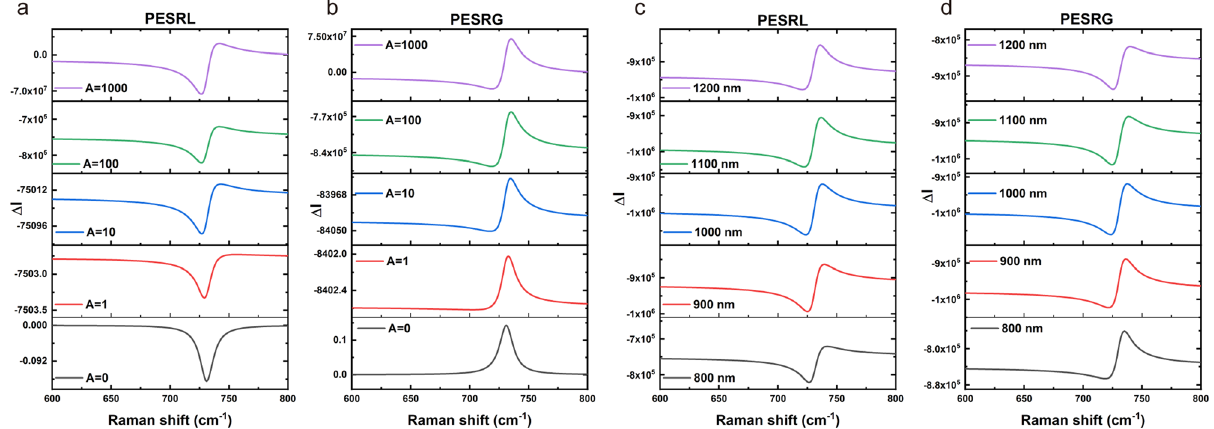
Figure 2: Simulation results. (a – b) Simulated plasmon-enhanced stimulated Raman loss (PESRL) (a) and plasmon-enhanced stimulated Raman gain (PESRG) (b) as a function of the plasmonic enhancement factor, A . The plasmon peak is kept at 800 nm. (c – d) Simulated PESRL (c) andPESRG(d) as afunctionof the plasmonpeak Ω R andenhancementfactoris keptat 100.Forall simulations, thepumpandStokesbeam wavelengths arecenteredat 969nmand1040nm,respectively.The Ramanpeakis centeredat 731cm − 1 with anhalfwidthat heightmaximum (HWHM) of 7 cm − 1 . The photothermal effect (PT) constant C is set as −